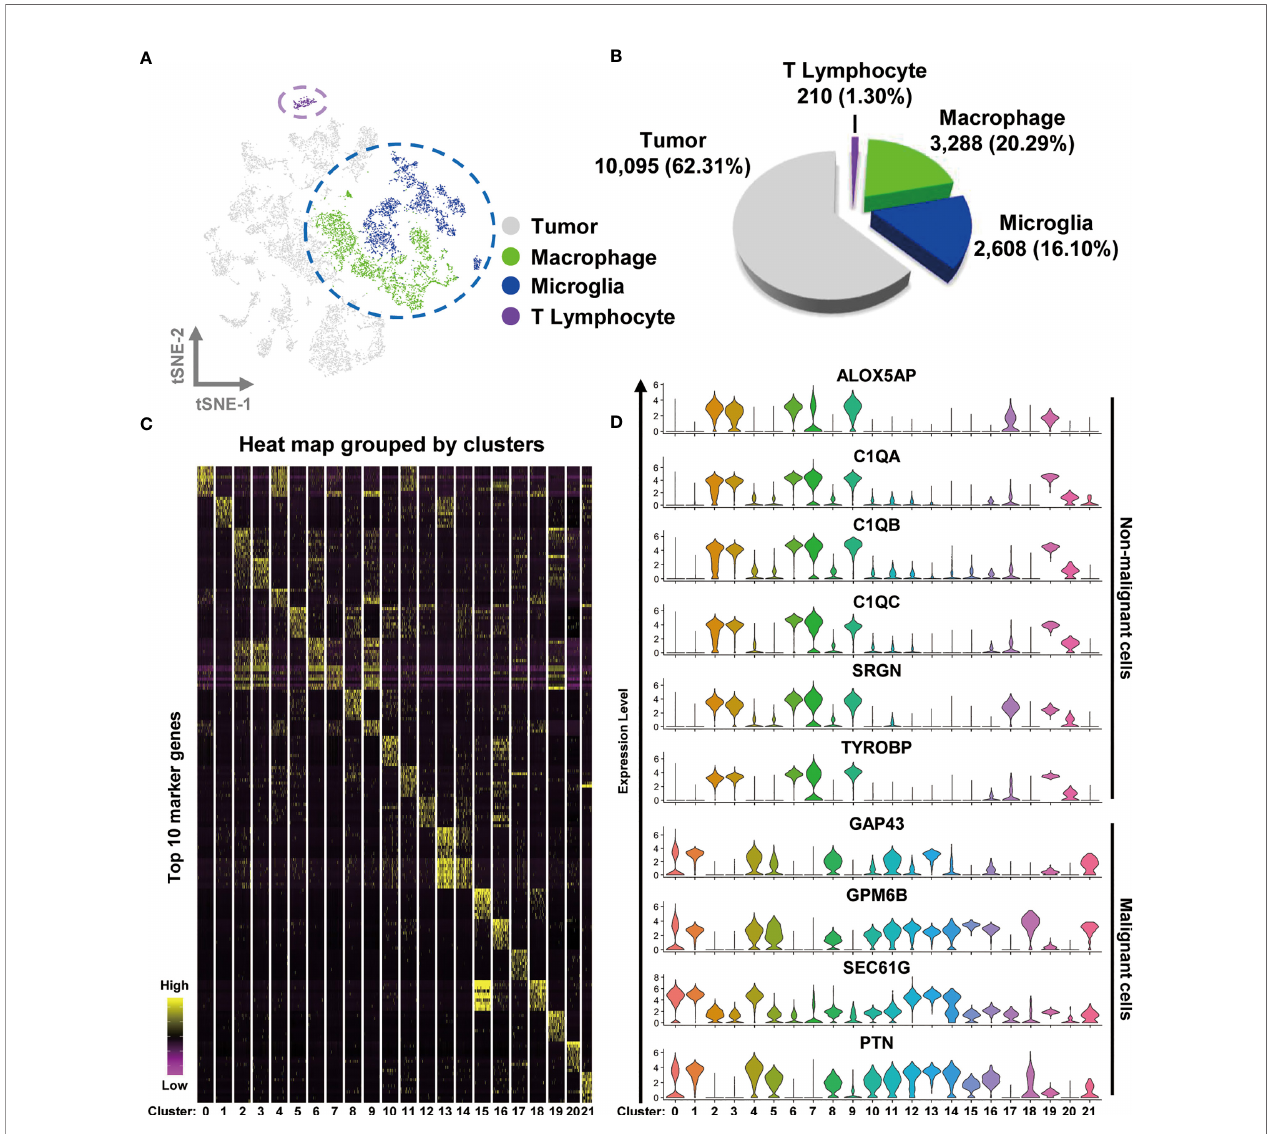
FIGURE 1 | Integrated scRNA-seq analysis from human GBM biopsies. (A) A total of 16,201 cells from nine datasets of fresh GBM tissues are visualized by the t-SNE plot. Distinct cell types are represented as follows: light gray indicates tumor cells, green indicates macrophages, cyan indicates microglia, and purple indicates T lymphocytes. (B) A pie chart illustrates the proportions of each cell type. (C) The expression pro fi les of the top 10 marker genes of each cluster are displayed as a heat map. (D) Distributions of malignant and non malignant cell marker genes are shown as violin